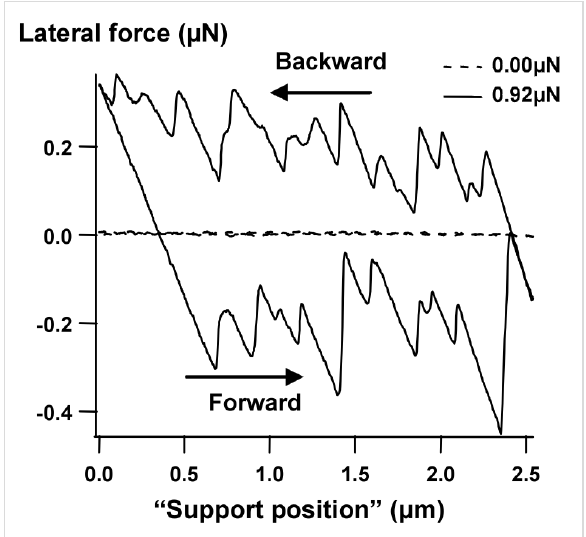
Figure 2: Typical 1000-cycle-average friction loops obtained with the tribometer of Figure 1 [19], at 27 °C and a relative humidity (RH) of 30%. The sliding speed was constant at 5 µm/s. Support position 0 μ m is where the loop was started every cycle. This loop is an average over 1000 scans. The fact that the slips appear sharp means that there was no significant change to their position over these 1000 scans and hence no surface changes (which would indicate wear). [Reprinted with permission from van Spengen, W. M.; Frenken, J. W. M. Tribol.